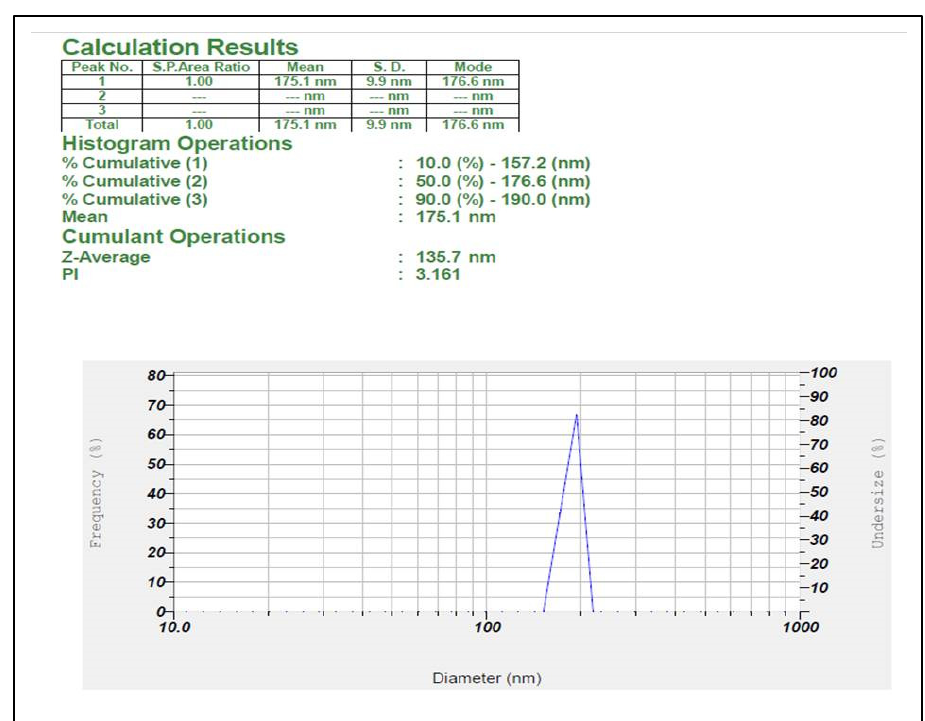
Figure 7. Analysis of particle size of V. leucoxylon FeNPs.